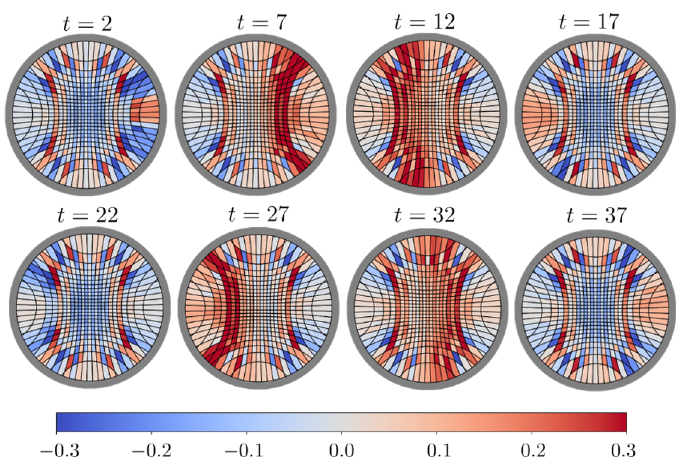
Figure 5. Quenched time dynamics of the reconstructed geometry corresponding to a single mass deformation along the x -axis (see figure 4 for the t = 0 geometries). Only the dominant component h 11 is shown here. The average reconstruction error over time is E bdy ≈ 0 . 52